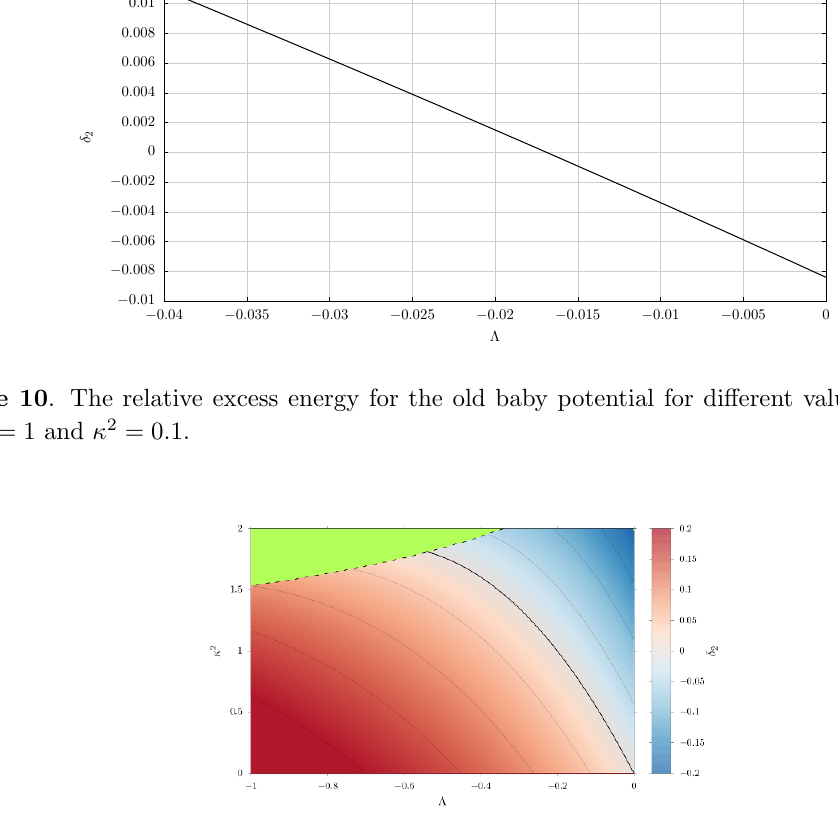
Figure 11 . Regions of positive and negative excess energy (cid:14) 2 in the (cid:3)- (cid:20) 2 plane. The green region close to the upper left corner corresponds to parameter values where a n = 2 soliton solution does not exist, i.e., n max = 1. Here (cid:21) = (cid:22) =